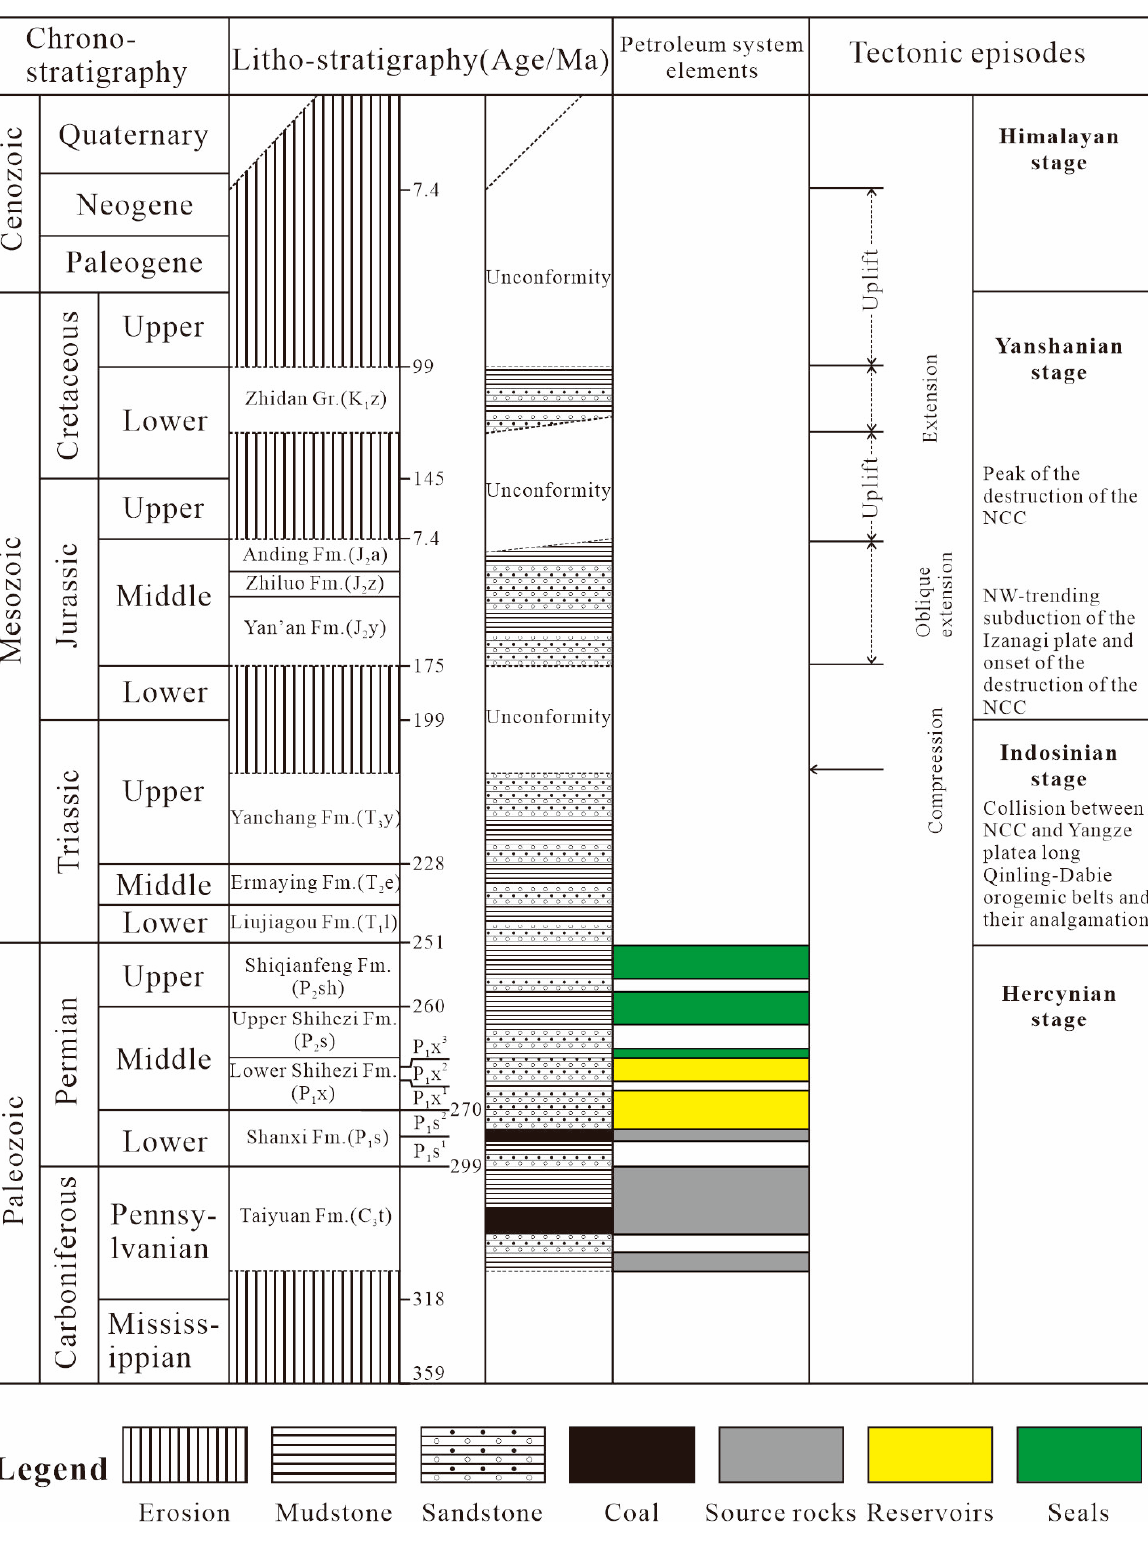
Figure 2. Generalized stratigraphy section of the Hangjinqi area, northern Ordos Basin. Abbreviations: NCC: North China Craton (modified after [57]).